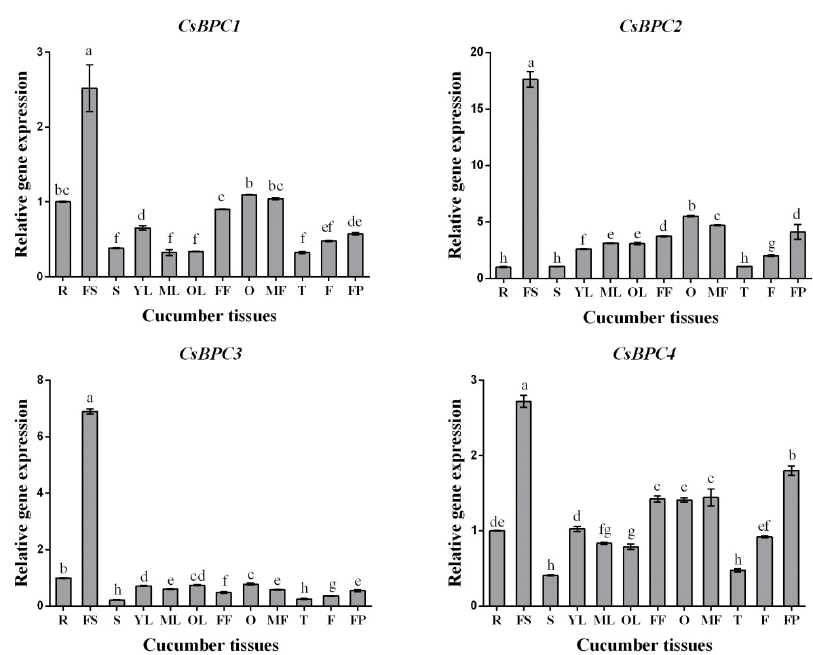
Figure 4. Expression analysis of CsBPC genes in different tissues. Transcript levels of CsBPCs were analyzed by qRT-PCR in roots (R), stems (S), top young leaves (YL), middle mature leaves (ML), basal old leaves (OL), blooming male flowers (MF), blooming female flowers with ovaries removed (FF), ovaries (O), tendrils (T), fruits (F), mature fruits’ seeds (FS), and pulps (FP). The expression levels of roots were defined as 1. Values are means ± SD ( n = 3). Different letters indicate significant differences ( p < 0.05).